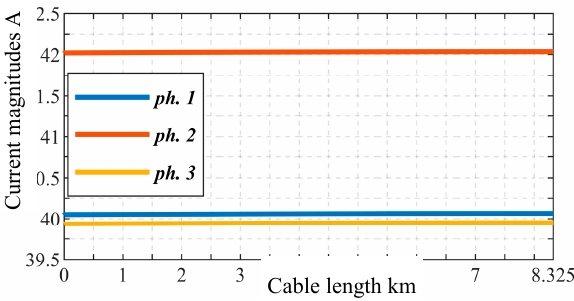
Figure 6. Current magnitudes in the three phases for case #1 (current magnitudes).